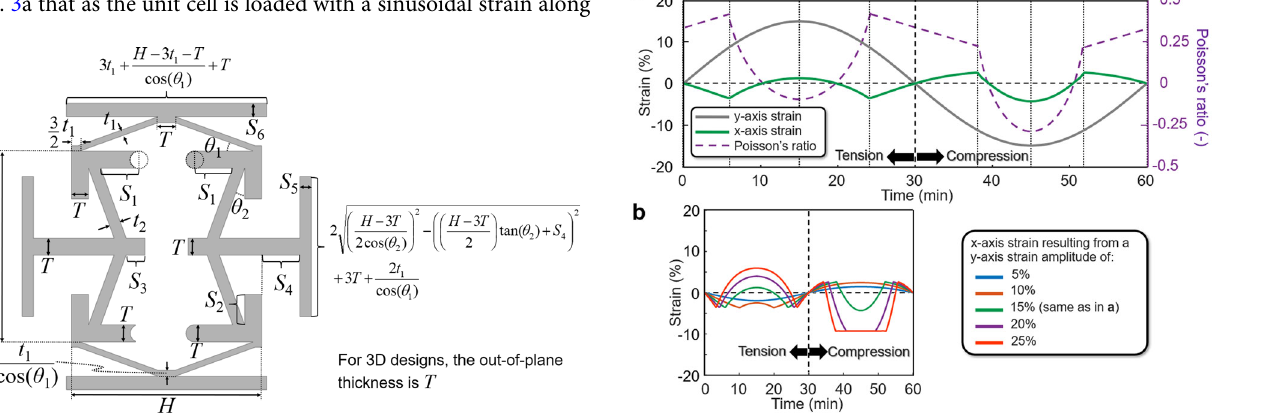
Fig. 2 Geometric parameters that de fi ne the proposed metamaterial unit cell concept. The parameters can be tuned to achieve different alternating Poisson ’ s ratios over time according to how the cell is loaded. Note that the design is symmetric about the dotted red horizontal line and is almost symmetric about the dotted blue vertical line except for the circular hard stops labeled Hard stop (1) in Fig. 1b.